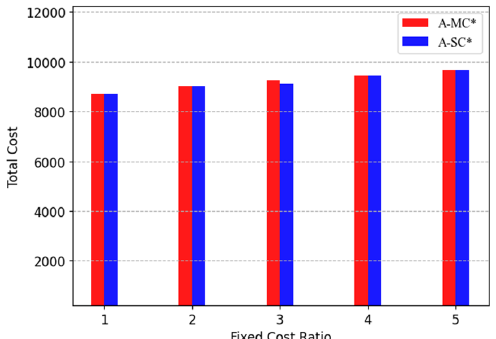
Fig. 5. Influence of different fixed cost ratios on total cost